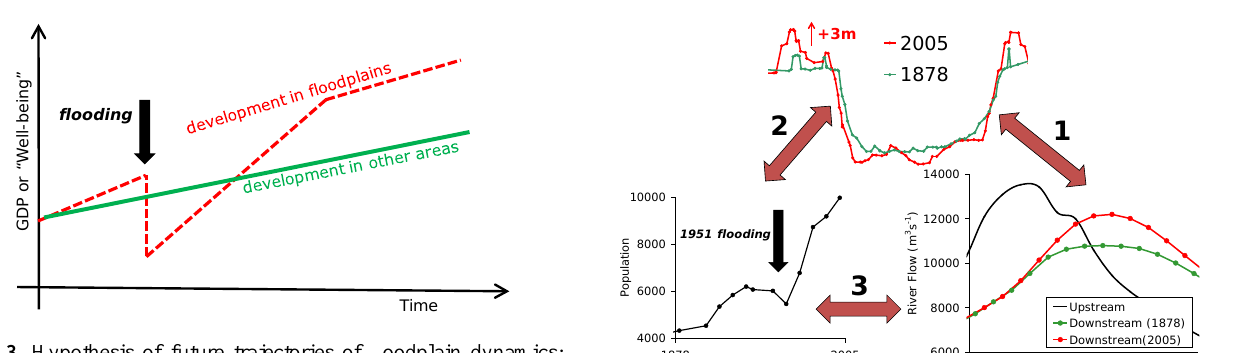
Fig. 3. Hypothesis of future trajectories of floodplain dynamics: Figure 3. Hypothesis of future trajectories of floodplain dynamics: flood disasters as shocks to 4 flood disasters as shocks to the system (after Green et al., 2011), the system (after Green et al., 2011), whereby the frequency and severity of floods will 5 whereby the frequency and severity of floods will eventually deter- eventually determine if development in the floodplain (red dotted line) is more or less 6 mine if development in the floodplain (red dotted line) is more or less desirable than development in other areas (green line). desirable than development in other areas (green line). 7